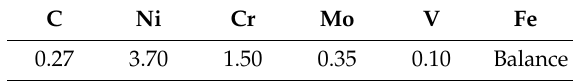
Table 1. Chemical composition of the used steam turbine steel in